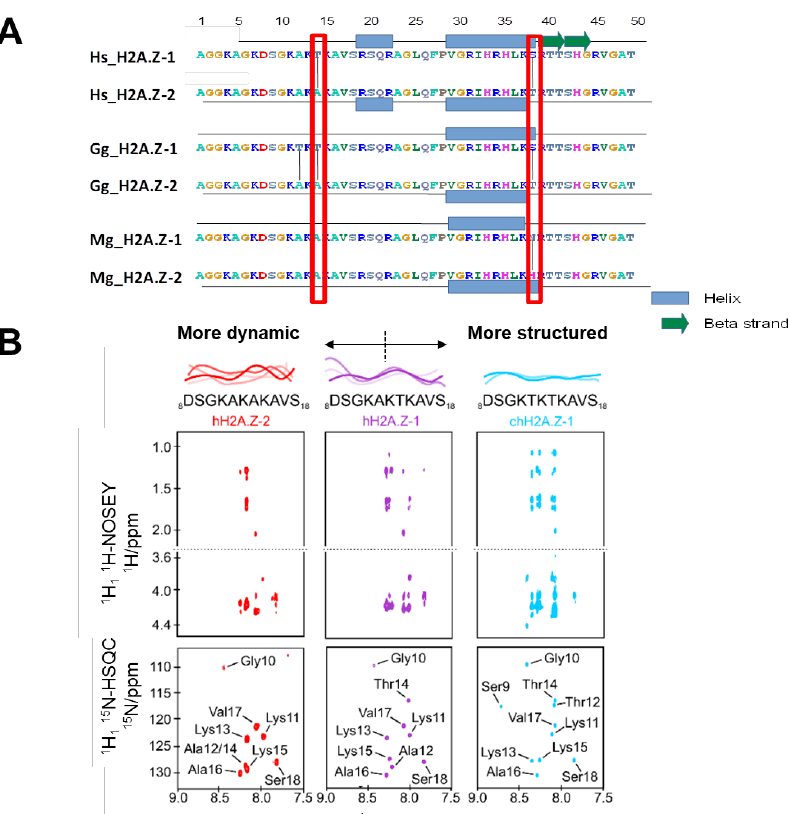
Figure 3. ( A ) Amino acid sequence of the first 49 amino acids of H2A.Z-1 and H2A.Z-2 isoforms and schematic representation of the secondary structure prediction. The red boxes highlight the sites of amino acid sequence variation and the red arrow points to the extra site of variation in chicken H2A.Z-1. Hs: Homo sapiens ; Gg: Gallus gallus (chicken); and Mg: Mytilus galloprovincialis (blue mussel). ( B ) Variable dynamic properties within the H2A.Z N-terminal tails. Peptides corresponding to residues 8–18 in human H2A.Z.2, human H2A.Z.1 and chicken H2A.Z.1 were characterized